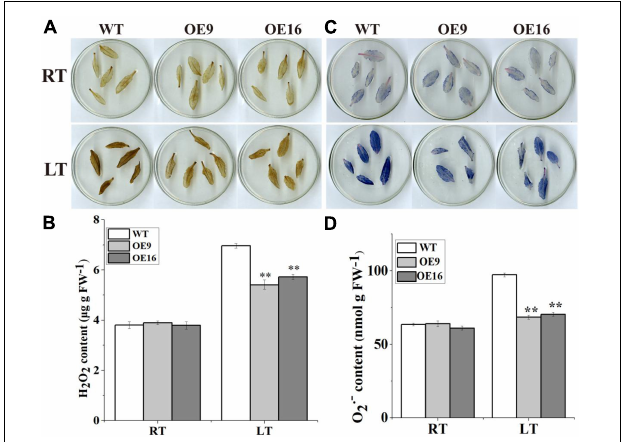
FIGURE 5 | The contents of ROS and the activities of antioxidant enzymes including in the wild-type (WT) and transgenic plants under 4 o C for 1 day. (A) DAB staining; (B) the content of H 2 O 2 ; (C) NBT staining; and (D) the content of O 2 – . The error bars represent the standard errors for three independent tests, and the asterisks ( ∗∗ ) indicate significant differences from the WT at p <